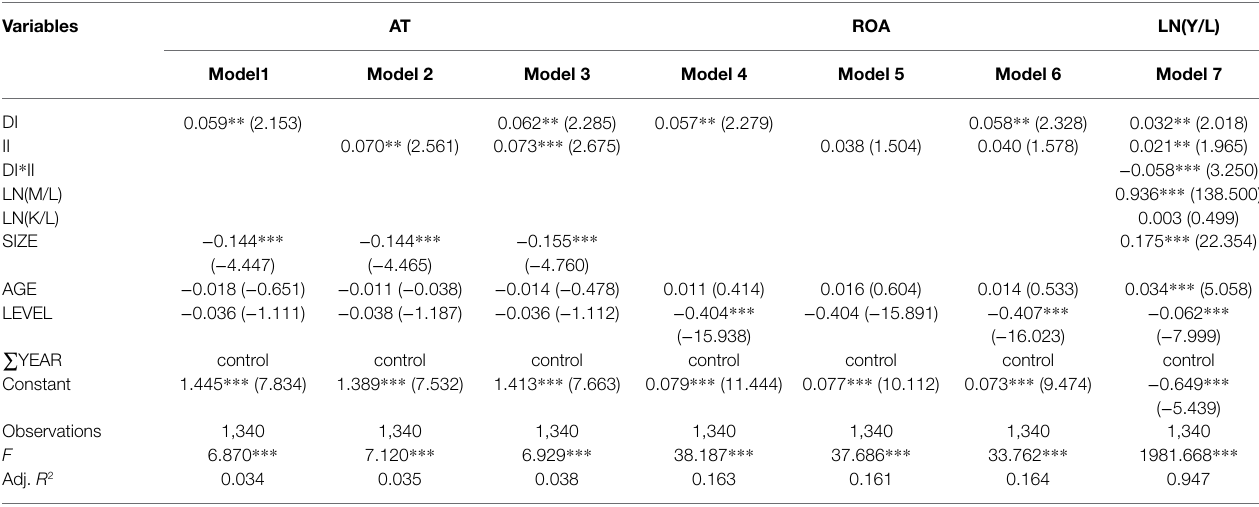
TABLE 3 | Regression analysis